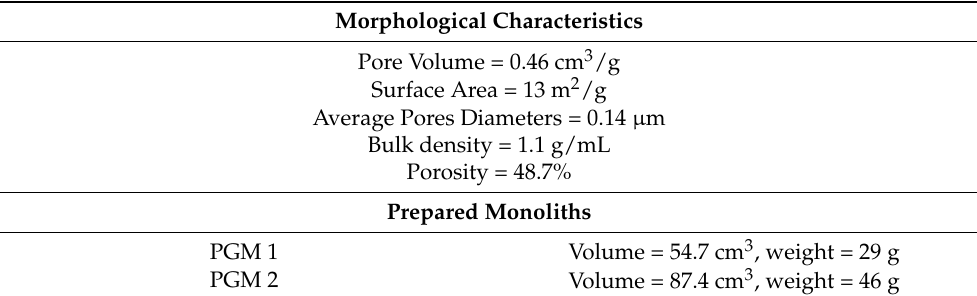
Table 4. Morphology and size of the monoliths.